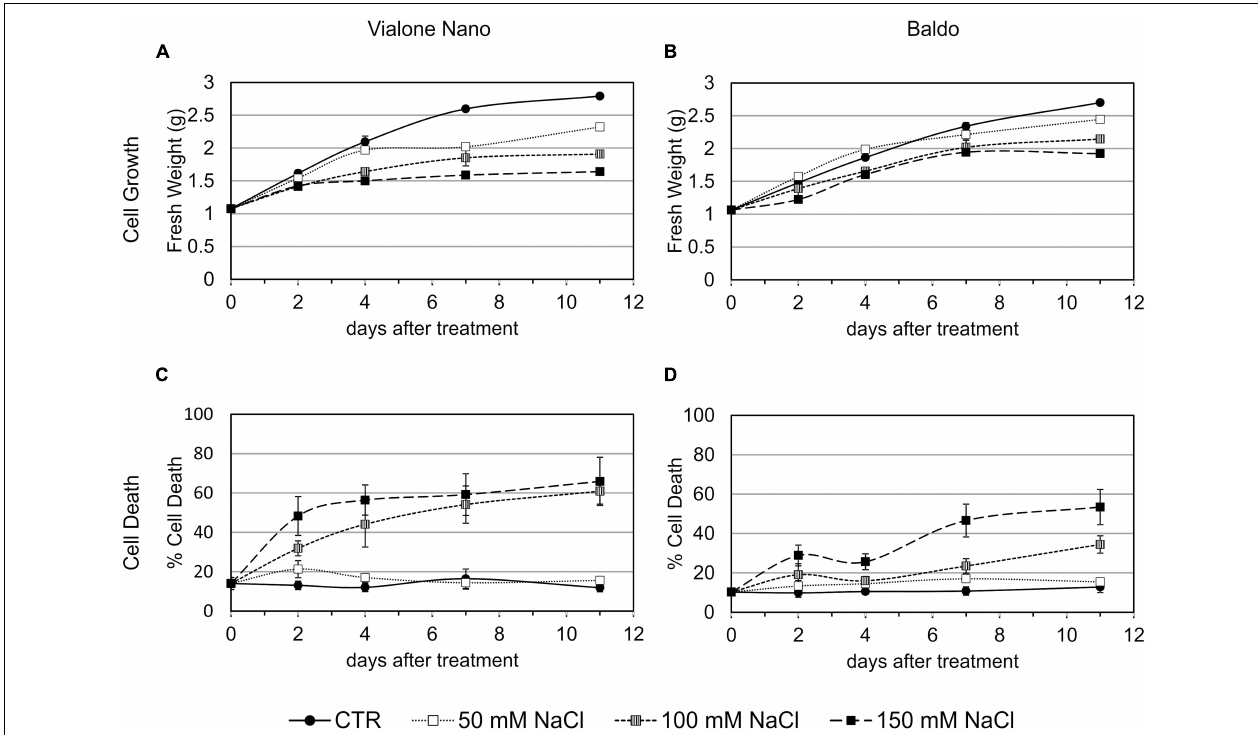
FIGURE 1 | Cell growth and cell death of B and VN suspension cultured cells in presence and absence of NaCl. Three-day-old VN (A,C) and B (B,D) cells were treated with different concentrations of NaCl. Closed circles – straight line, Control; open squares – dotted line, 50 mM NaCl; gray squares – small-dashed line, 100 mM NaCl; closed squares – dashed line, 150 mM NaCl. (A,B) Fresh weight (g) of cells at different times after treatment. (C,D) Cell death percentage (Evans blue staining). Values represent the mean ± SE of three independent experiments performed in triplicate.